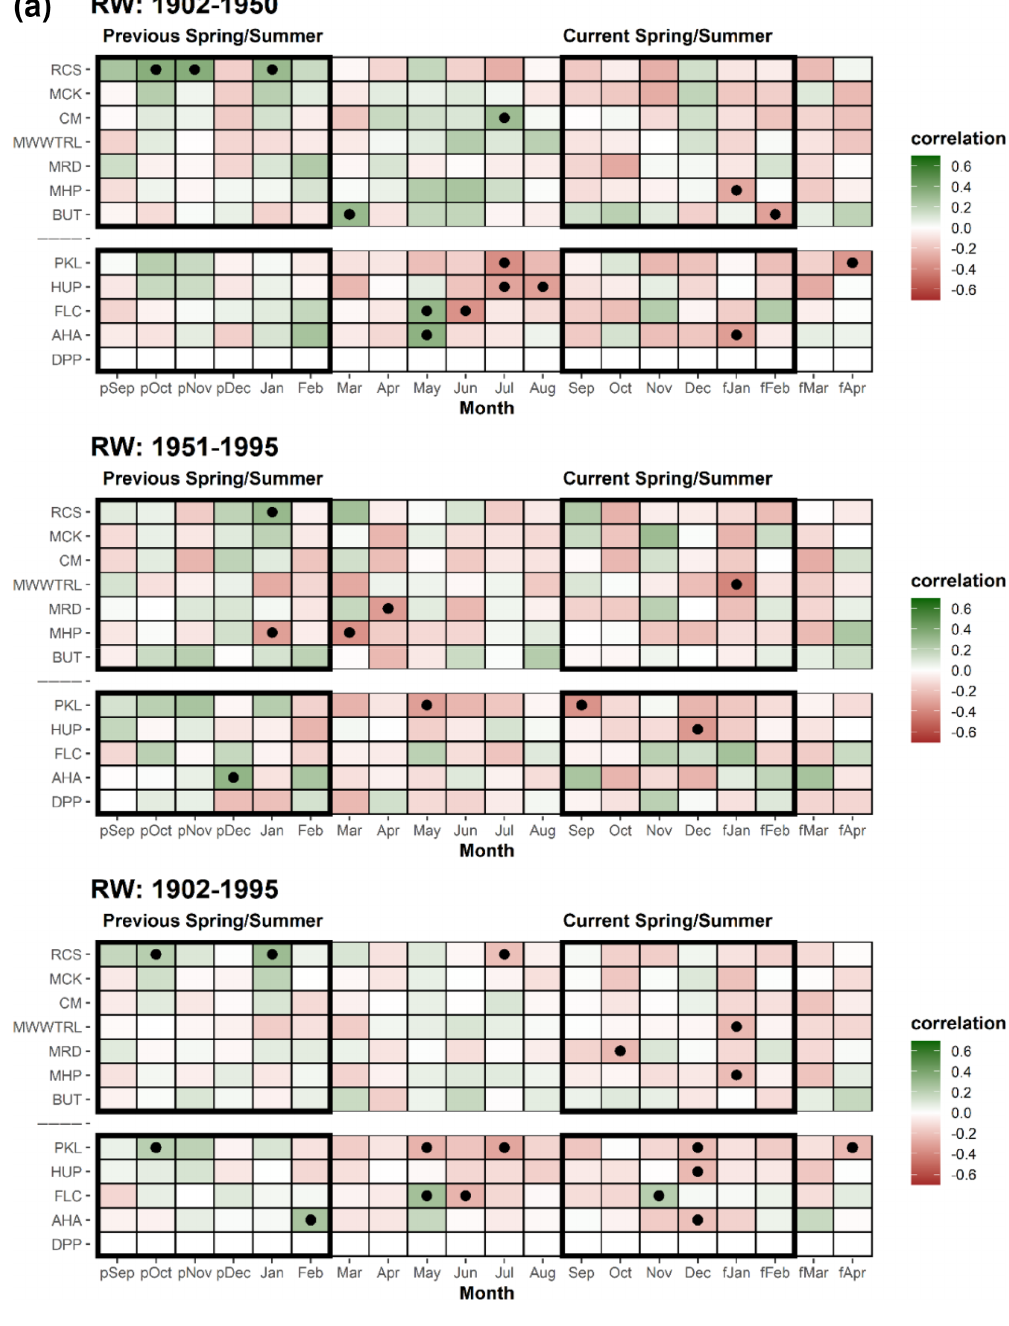
Table A4. (a) Correlation response function analysis for ring width with CRUTS precipitation. Analysis was undertaken over the 1902–1950, 1951–1995, and 1902–1995 periods. Black dots denoted correlations significant at the 95% confidence limit. (b) As 4a but for EWB. (c) As 4a but for LWB. (d) As 4a but for